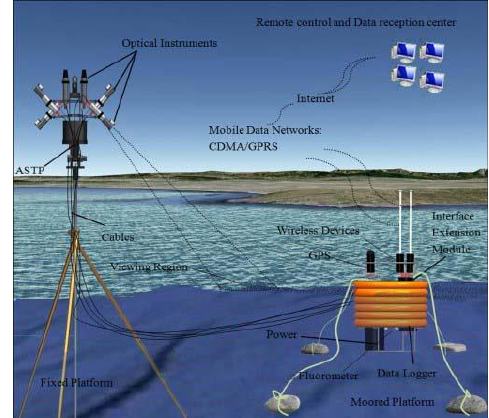
Figure 4. The deployment scheme for the AFWCPOS.